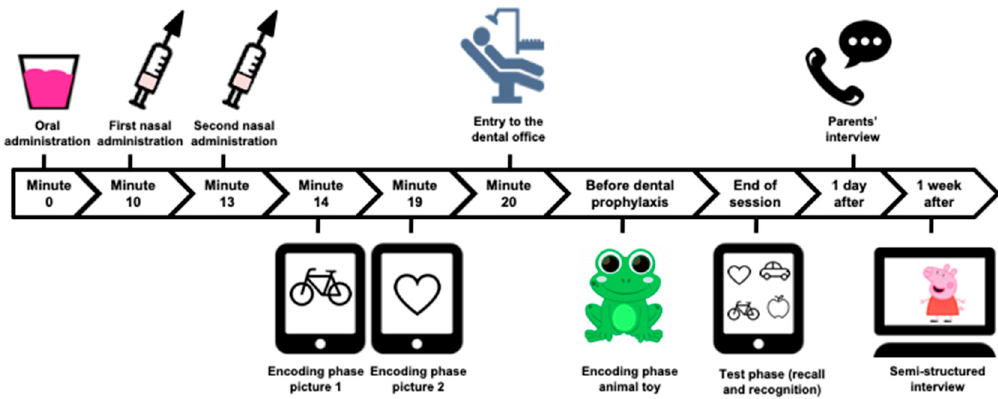
Figure 1. Steps of the amnesia assessment.